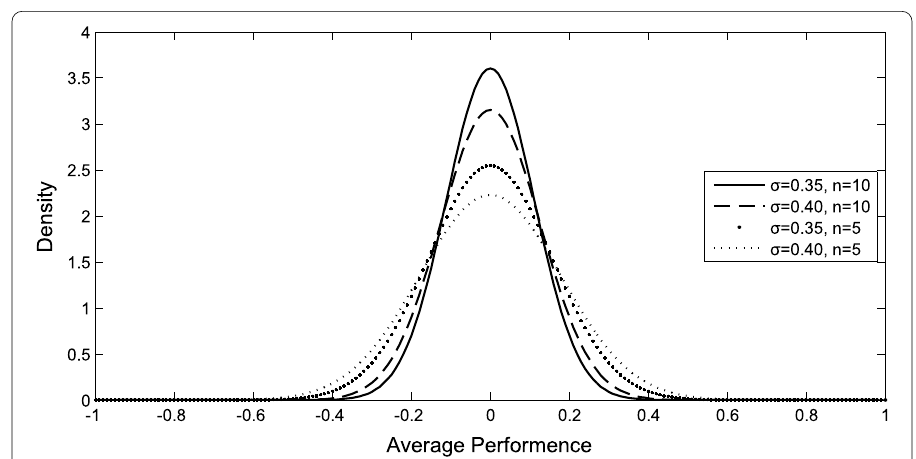
Fig. 4 Distributions of sample mean with different σ and